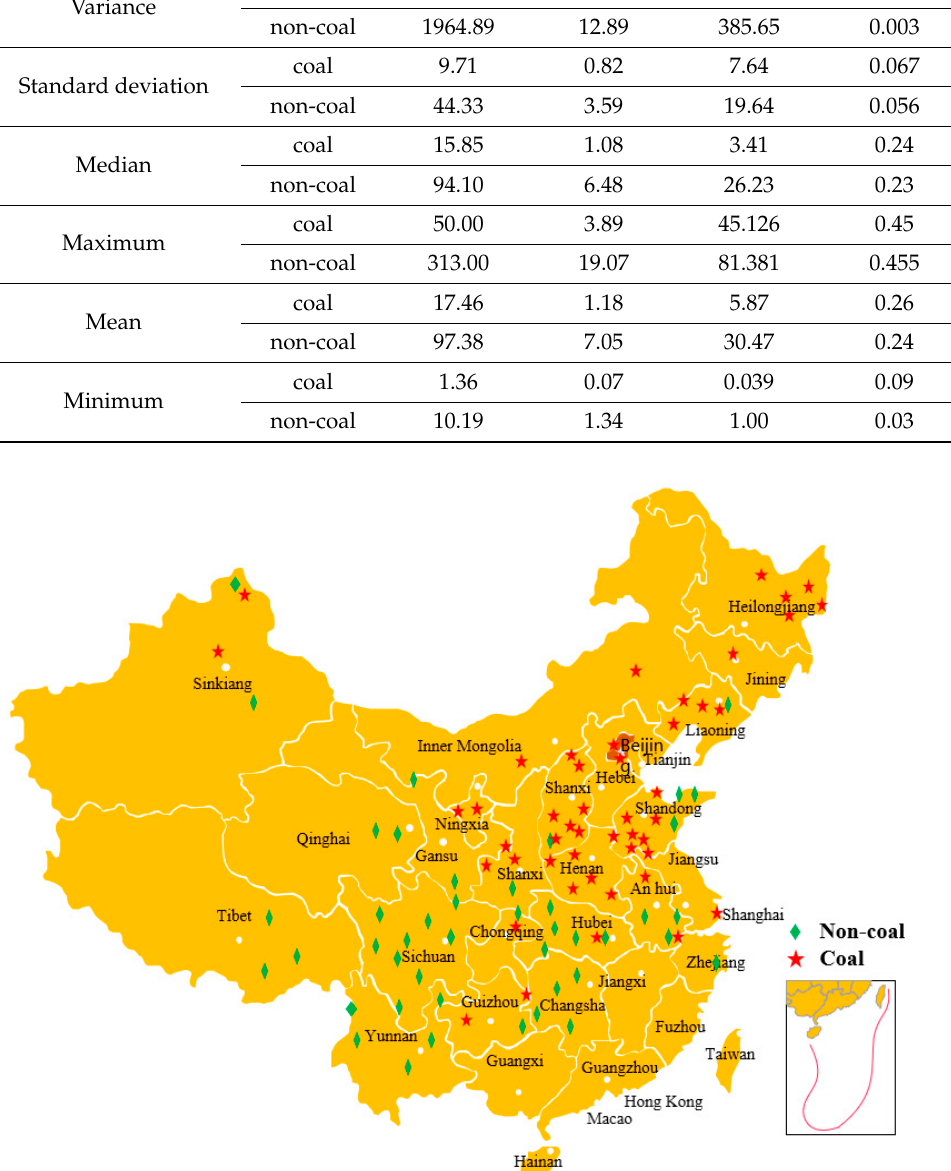
Figure 2. Regional distribution of the coals and non-coal rock examples used in this study.